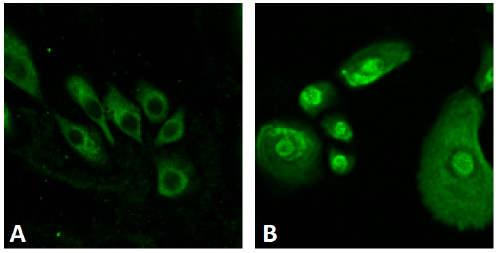
Figure 2. Activation of NRF2. In untreated normal human keratinocytes, NRF2 (green) is mainly located in the cytoplasm ( A ); Opuntia ficus ‐ indica extract activates NRF2 and induces its cytoplasmic to nuclear translocation ( B ).